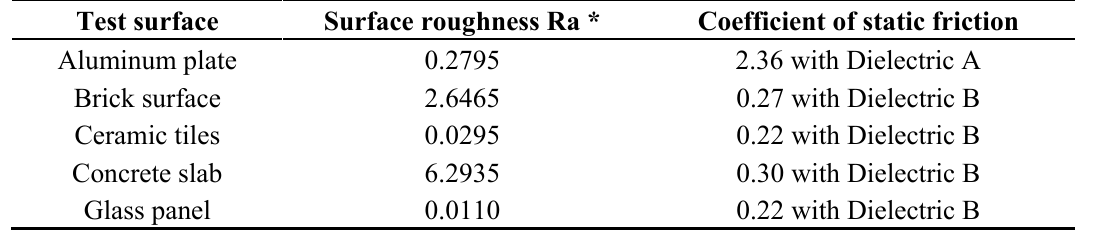
Table 2. Test surface information (obtained by